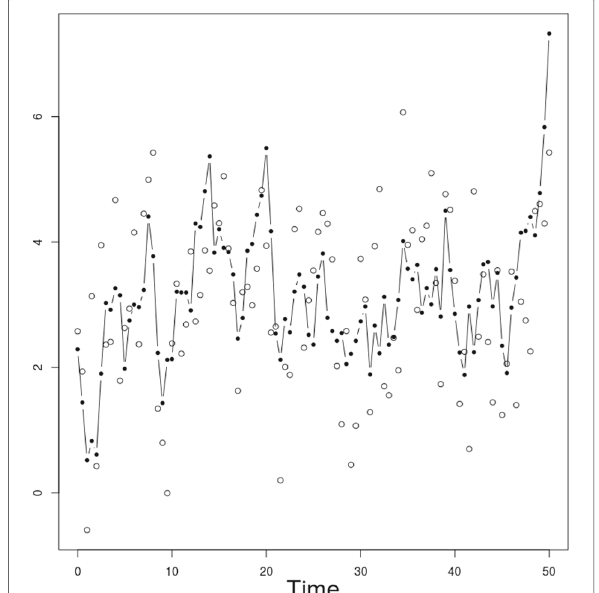
Fig. 1 SINE model - observations. Process X solution to the SDE (balls) and observations Y (circles) at times t 0 = 0, ... , t 100 = 50